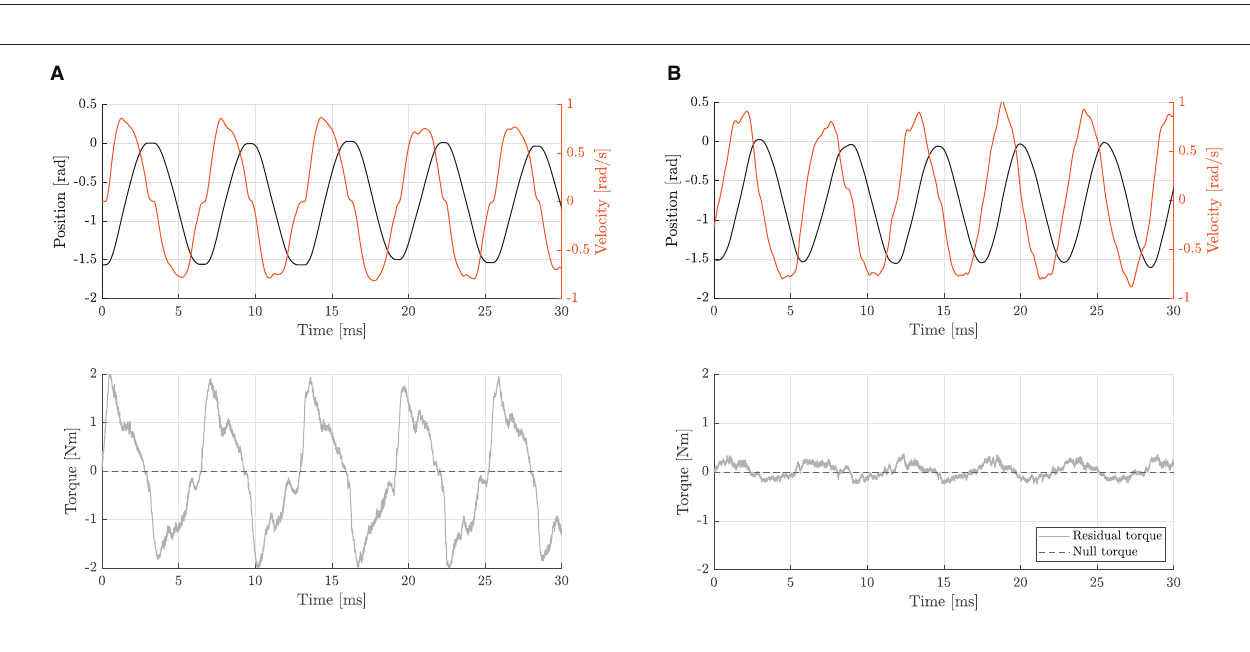
FIGURE 6 | Elbow flexion/extension movements. (A) Sketch representation of the elbow flexion/extension task exercise. (B) Trajectory β -function computed with P 0 = P 2 = 0, P 4 = 8, A 0 = 90 ◦ , and P 3 = P 5 = 5. Black lines represent elbow flexion phase, while blue lines represent elbow extension phase.